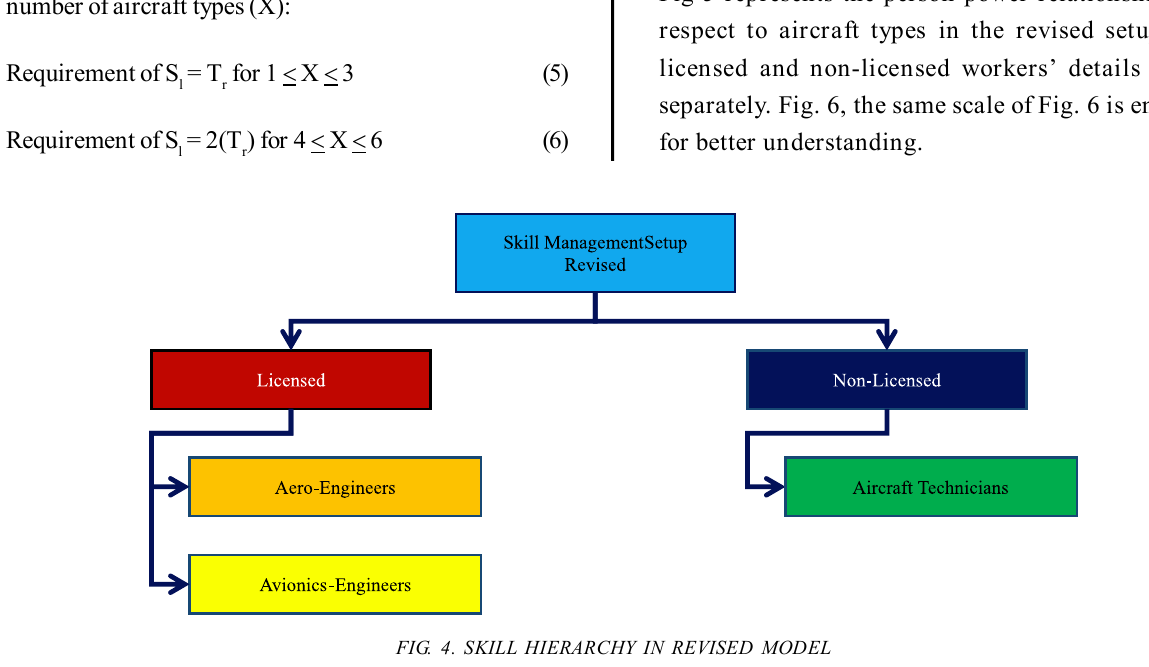
FIG. 4. SKILL HIERARCHY IN REVISED